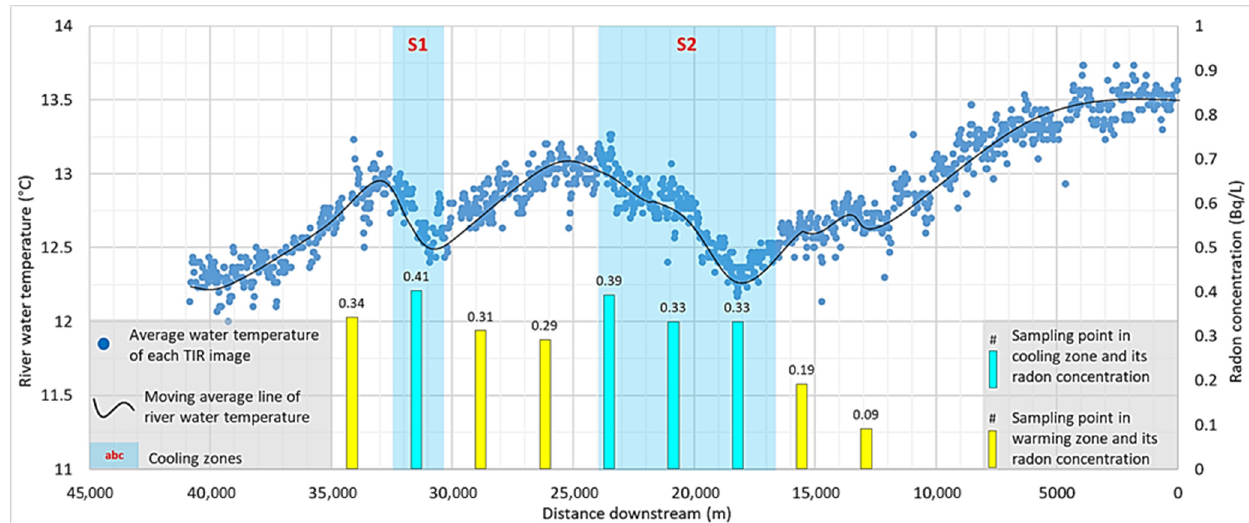
Figure 5. Scatter plot showing temperature profile of Sainte-Marguerite River and columns showing location of radon sampling and measured concentration.